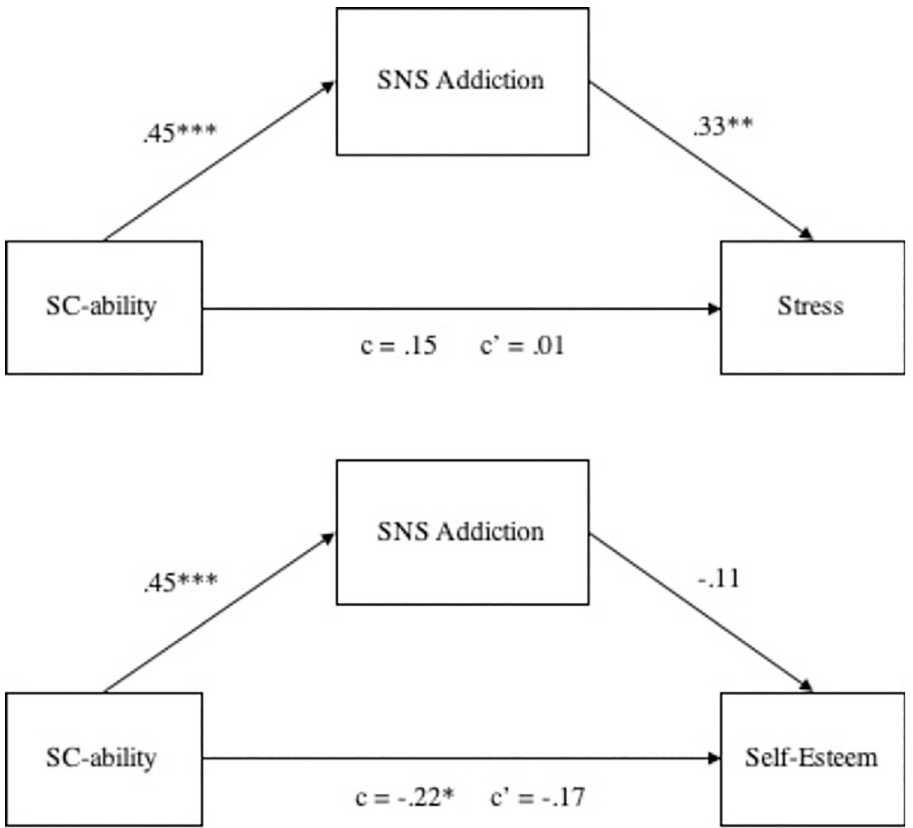
Fig 1. The mediating role of SNS addiction on the relations between social comparison of ability and stress, and self-esteem.